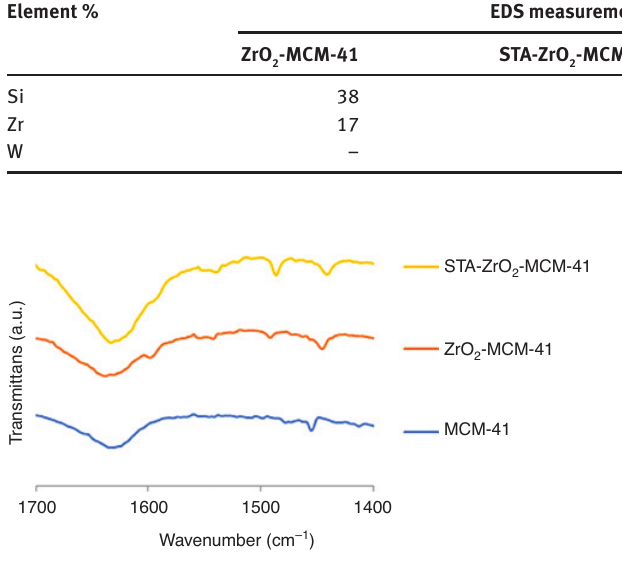
Figure 4: DRIFT spectrum of pyridine-adsorbed